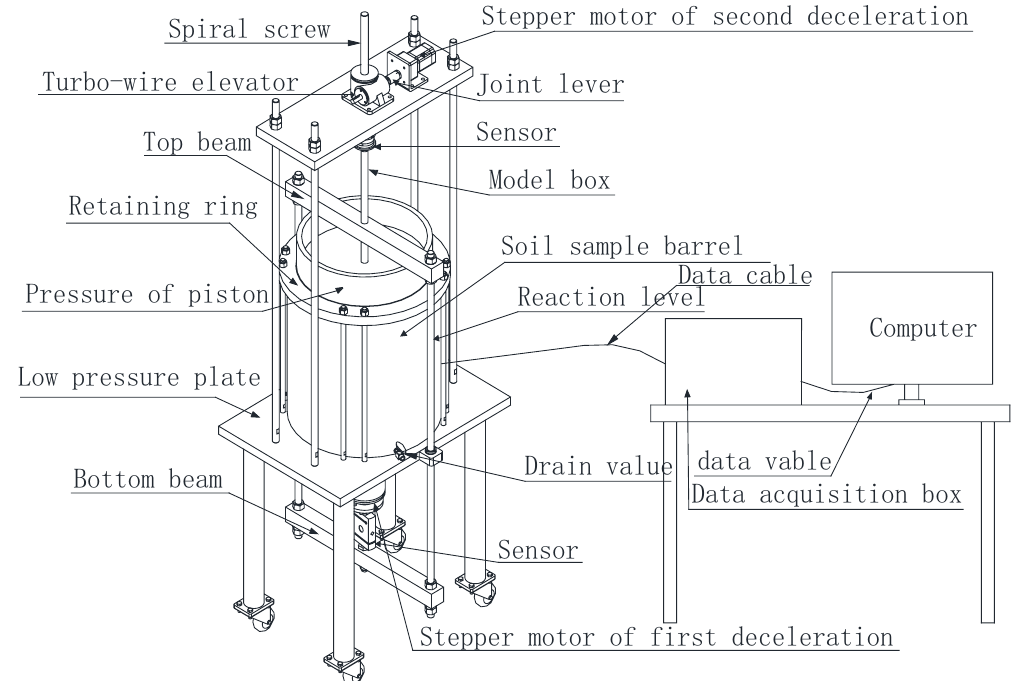
Figure 1. Overall schematic diagram for the model device.